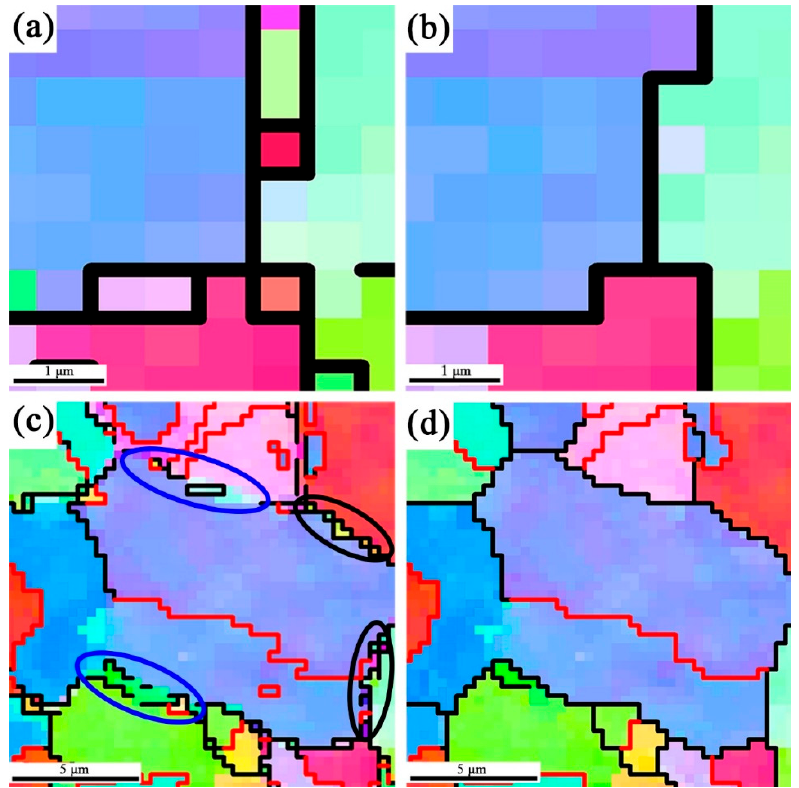
Figure 7. Reconstructed IPF map for measured data in Figure 6a by the criterion of ∆ θ ave minimization ( a ) and the newly proposed criterion ( b ). Reconstructed IPF map for measured data in Figure 5a by the criterion of ∆ θ ave minimization ( c ) and the newly proposed criterion ( d ). (Black lines: misorientation angles > 15° ; Red lines: Σ3 boundaries)